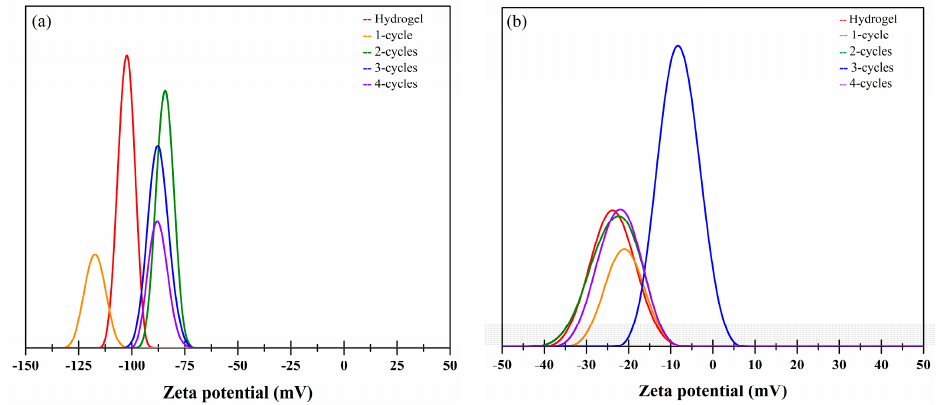
Figure 8 Figure 8. Zeta potential of the hydro- and the cryogels as a function of the freeze–thaw cycles. ( a ) xanthan; ( b ) karaya.